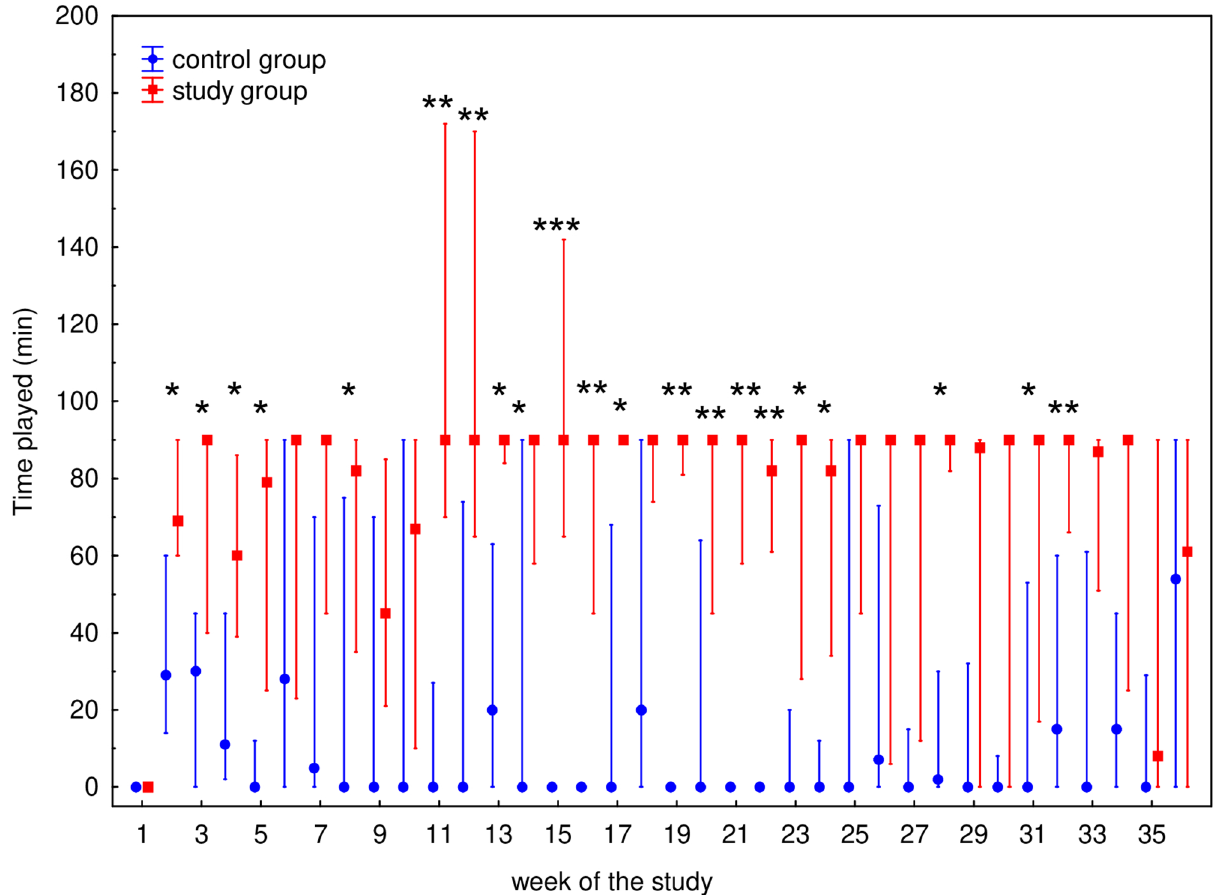
Figure 1. Median time played by 22 professional soccer players during 36-week study. The midpoint represents median; whiskers represent Q1–Q3 range. The significance of differences between the control and study